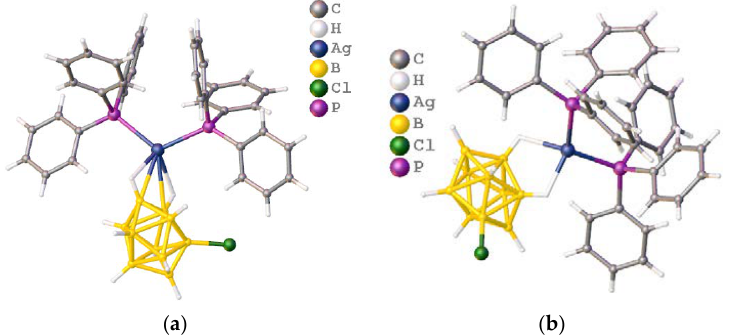
Figure 3. Structure of binuclear silver(I) complex [Ag 2 (Ph 3 P) 4 [B 12 H 11 Cl]].